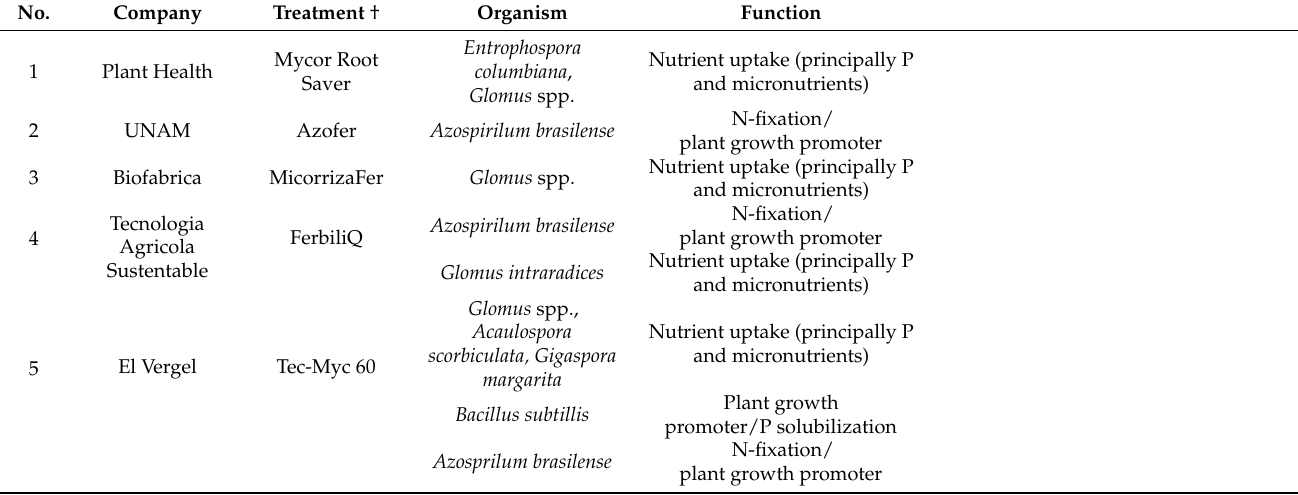
Table 5. List of treatments by groups or individual states and cycles where each treatment was tested (bottom of the Table), from 2012–2013, and from 2016–2019 in Mexico. The last column in the Table shows the function of biofertilizers in plants